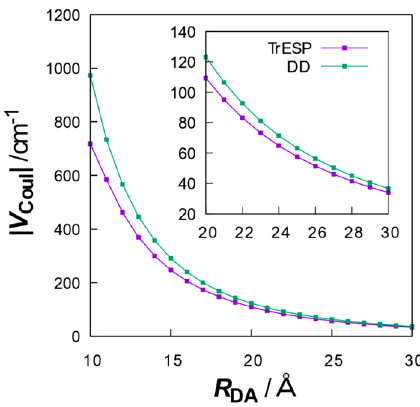
Figure 2. Electronic coupling values as a function of intermolecular A647-BChl1 distance R DA . The definition of R DA is shown in Fig. 1b.